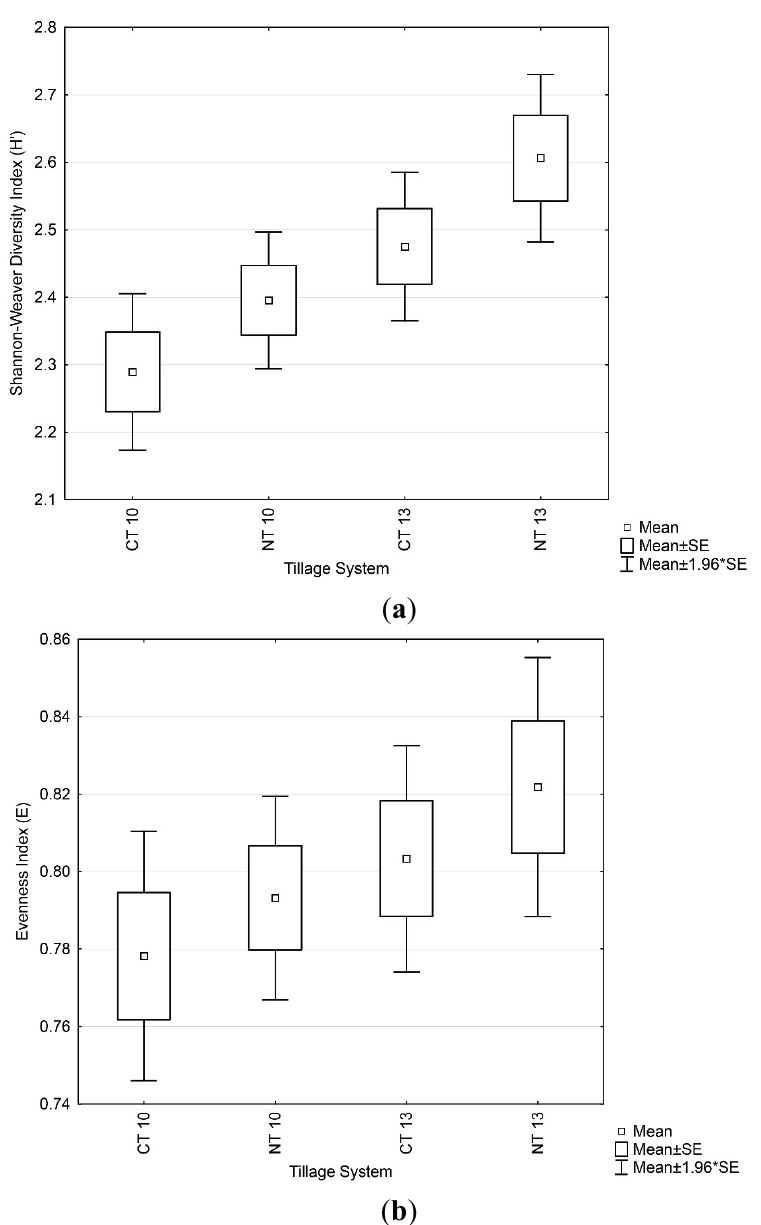
Figure 6. ( a ) Box and Whisker plots comparing the effect of tillage systems on soil microbial species richness (Shannon–Weaver Index) during the 2009/2010 and 2012/2013 planting seasons. ( b ) Box and Whisker plots comparing the effect of tillage systems on soil microbial species abundance (Evenness Index) during the 2009/2010 and 2012/2013 planting